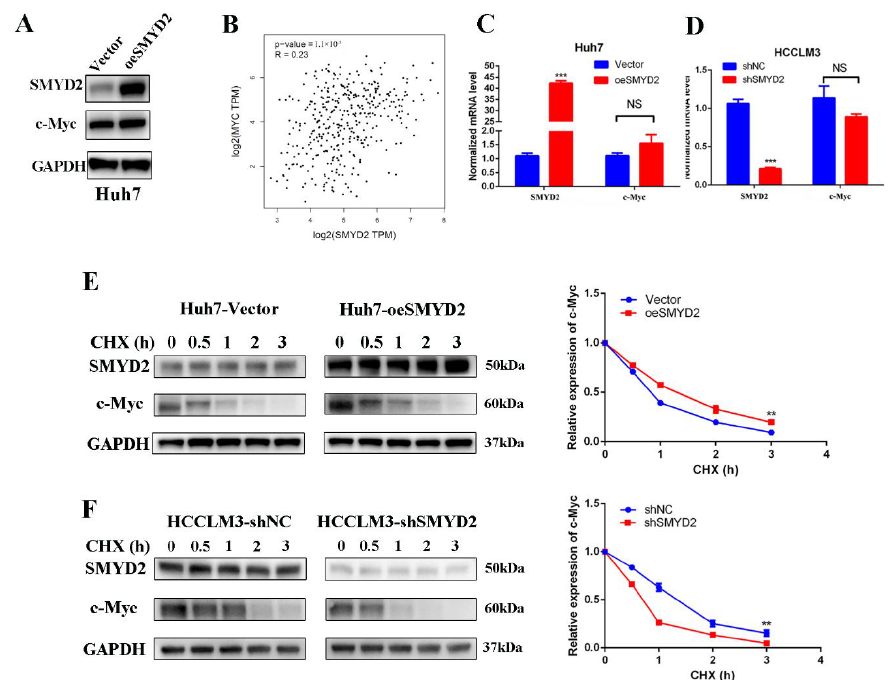
Figure 4. SMYD2 stabilizes c-Myc in HCC cells at the post-transcription level. ( A ) The protein level of c-Myc in the SMYD2-overexpressing Huh7 cells. ( B ) Scatter plot shows the lack of correlation between SMYD2 and c-Myc. ( C , D ) The mRNA level of c-Myc in SMYD2 overexpressed ( C ) and SMYD2 knockdown ( D ) HCC cell lines. Data are represented as mean ± SD. The data were analyzed by Student’s t -test. GAPDH served as the internal control. NS: not significant. *** p < 0.001. ( E ) Effect of cycloheximide (10 µ g/mL) on c-Myc in SMYD2 overexpressed HCC cells at several time points. The expression of SMYD2 and c-Myc was examined by Western blot ( left ) and semi- quantification ( right ).** p < 0.01. ( F ) Effect of cycloheximide (10 µ g/mL) in SMYD2 knockdown HCCLM3 cells in the indicated times. ** p <